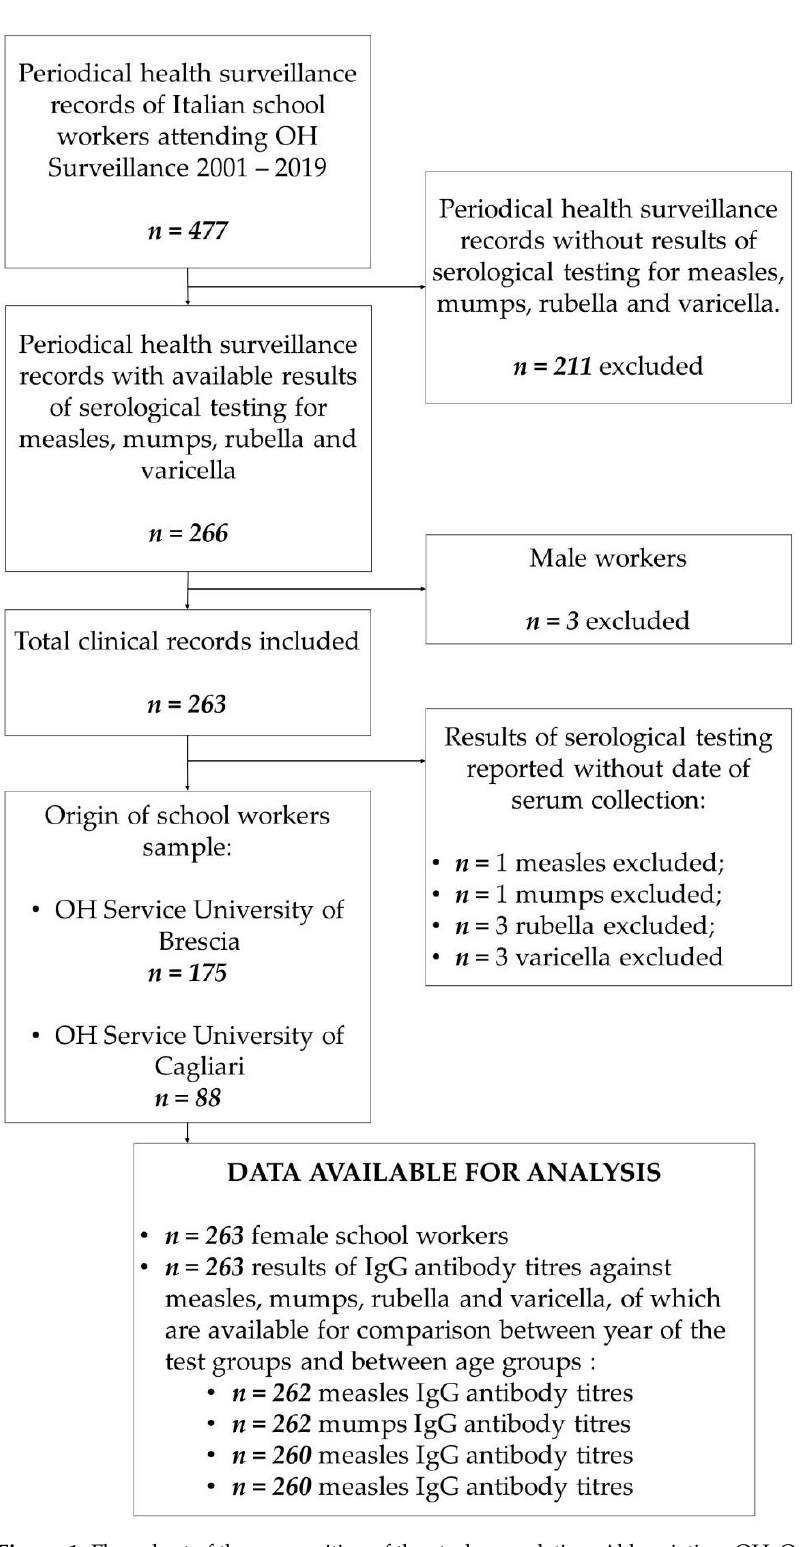
Figure 1. Flow chart of the composition of the study population. Abbreviation: OH, Occupational Health. Distribution of the